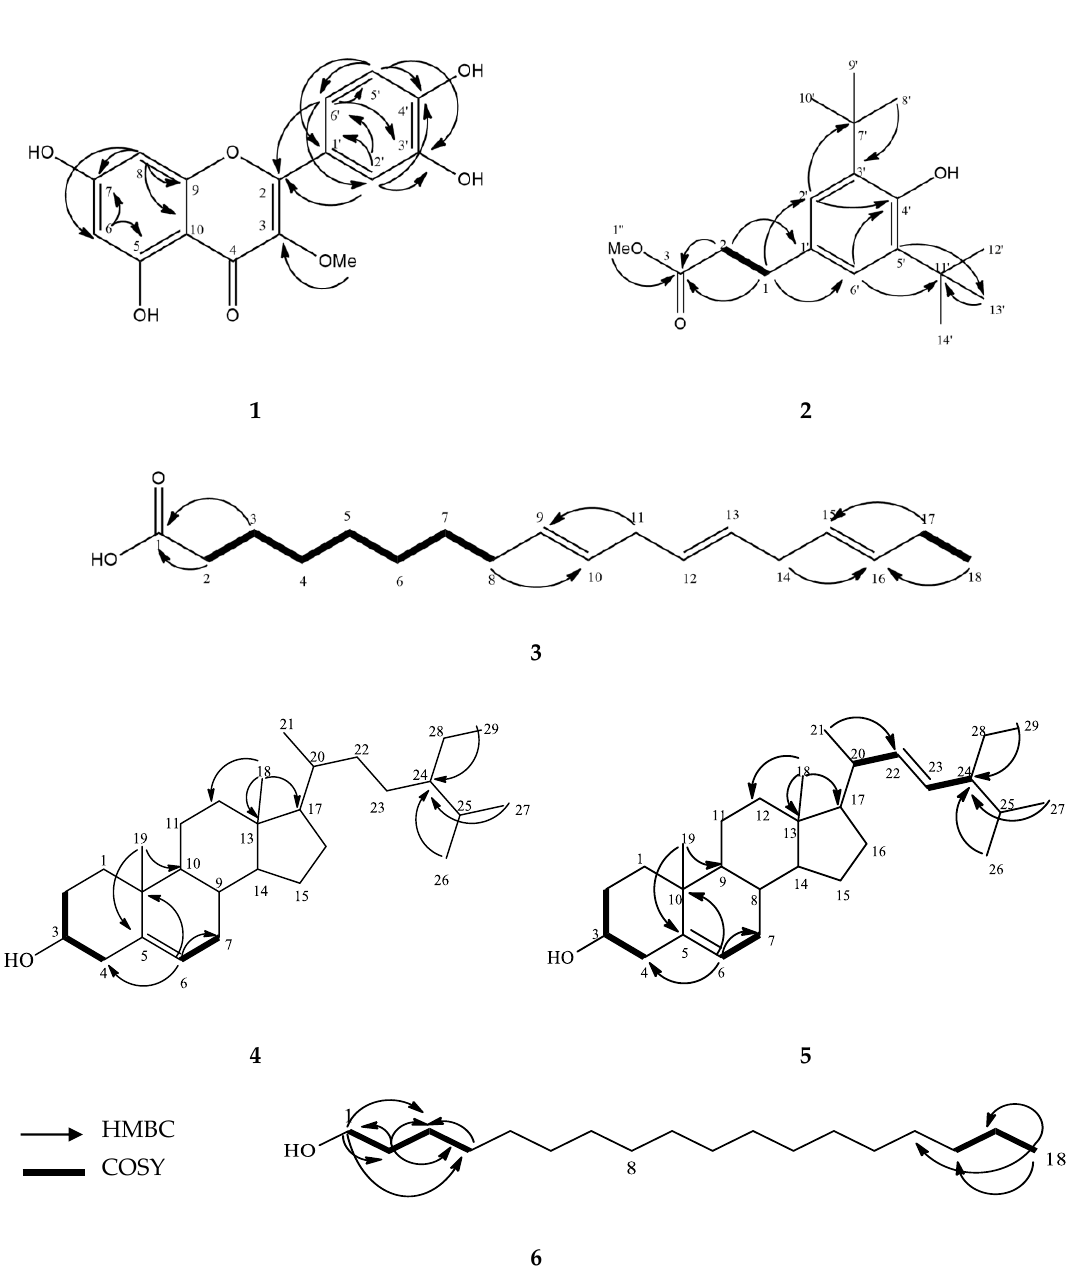
Figure 2. HMBC and COSY key correlations of compounds 1 – 6 .